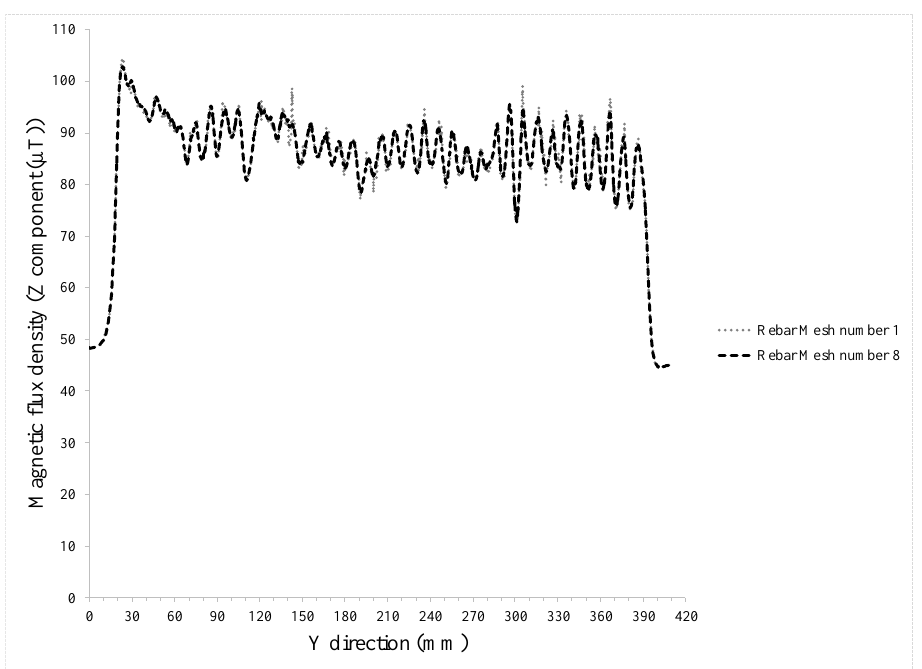
Figure 10. Comparison between the values of Z-component magnetic flux density of rebar mesh #8 and rebar mesh #1, with fixed box mesh (box mesh #1).